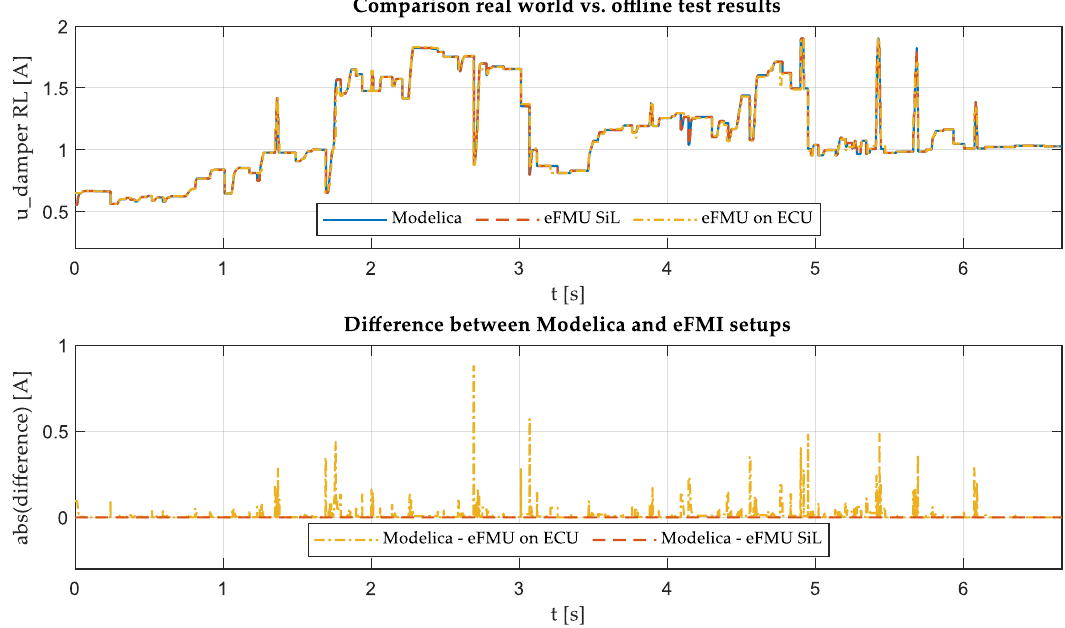
Figure 16. Comparison: Logged controller output during a test drive (eFMU on ECU) and the simulated controller with test drive excitation for the Modelica and eFMI production code (eFMU SiL) controller version. Rear left (RL) damper current (u_damper).